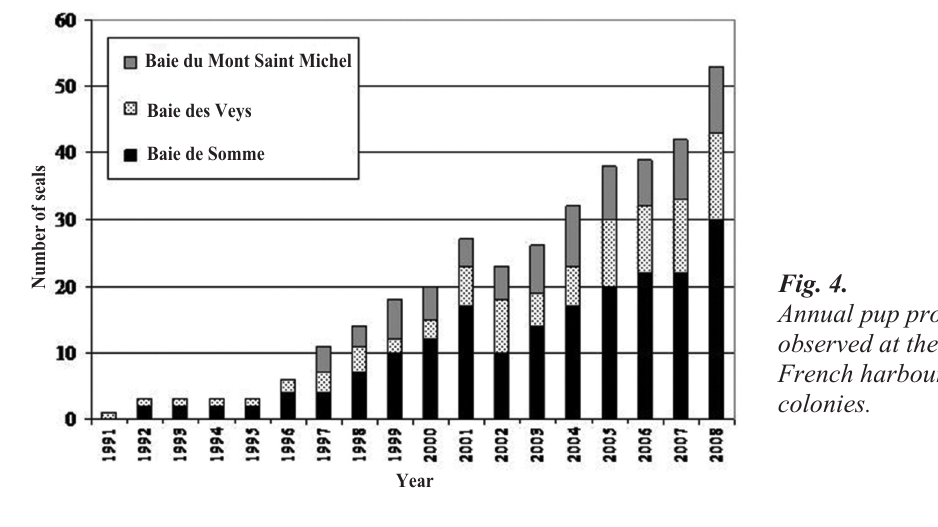
Fig. 4. Annual pup production observed at the three French harbour seal